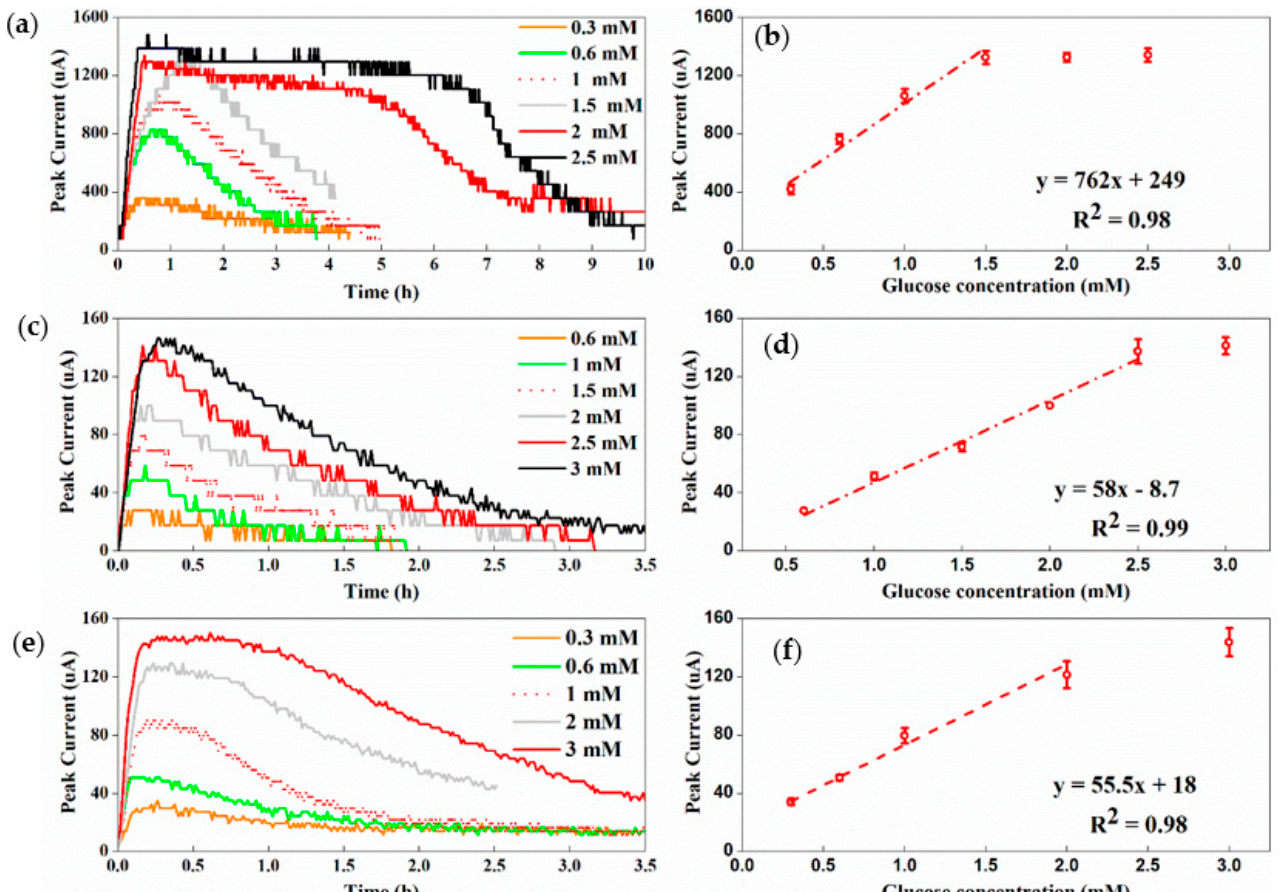
Figure 3. ( a ) Current curves as a response to different concentrations of glucose solutions for FS1; ( b ) the linear correlation graphs between glucose concentration and the peak current of FS1; ( c ) current curves as a response to different concentrations of glucose solutions for FS2; ( d ) the linear correlation graph between glucose concentration and the peak current of FS2; ( e ) the CS current curves as a response to different concentrations of glucose with different concentration; ( f ) the linear correlation between glucose concentration and the peak current of the CS.